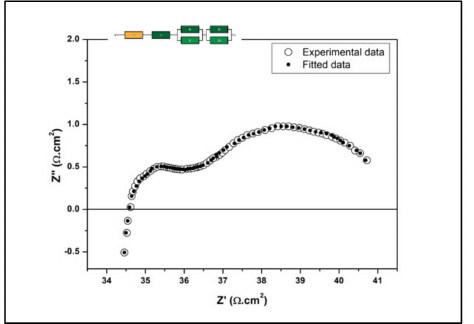
Figure 5. Impedance spectrum of NiO-BCZY|BCZY|LSCF-BCZY single cell at 700 ◦ C under hydro- gen/air